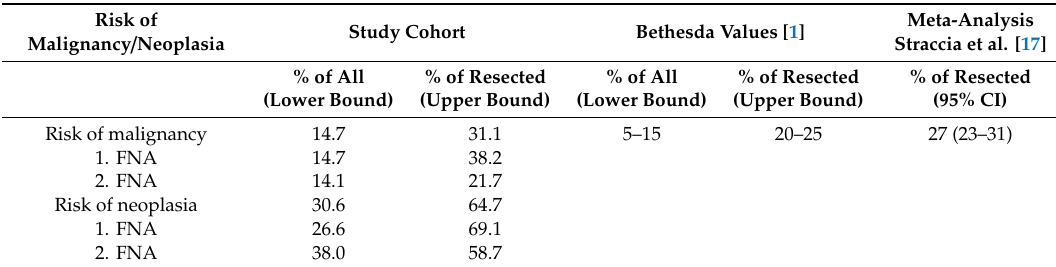
Table 2. The risk of malignancy and neoplasia in AUS/FLUS category.